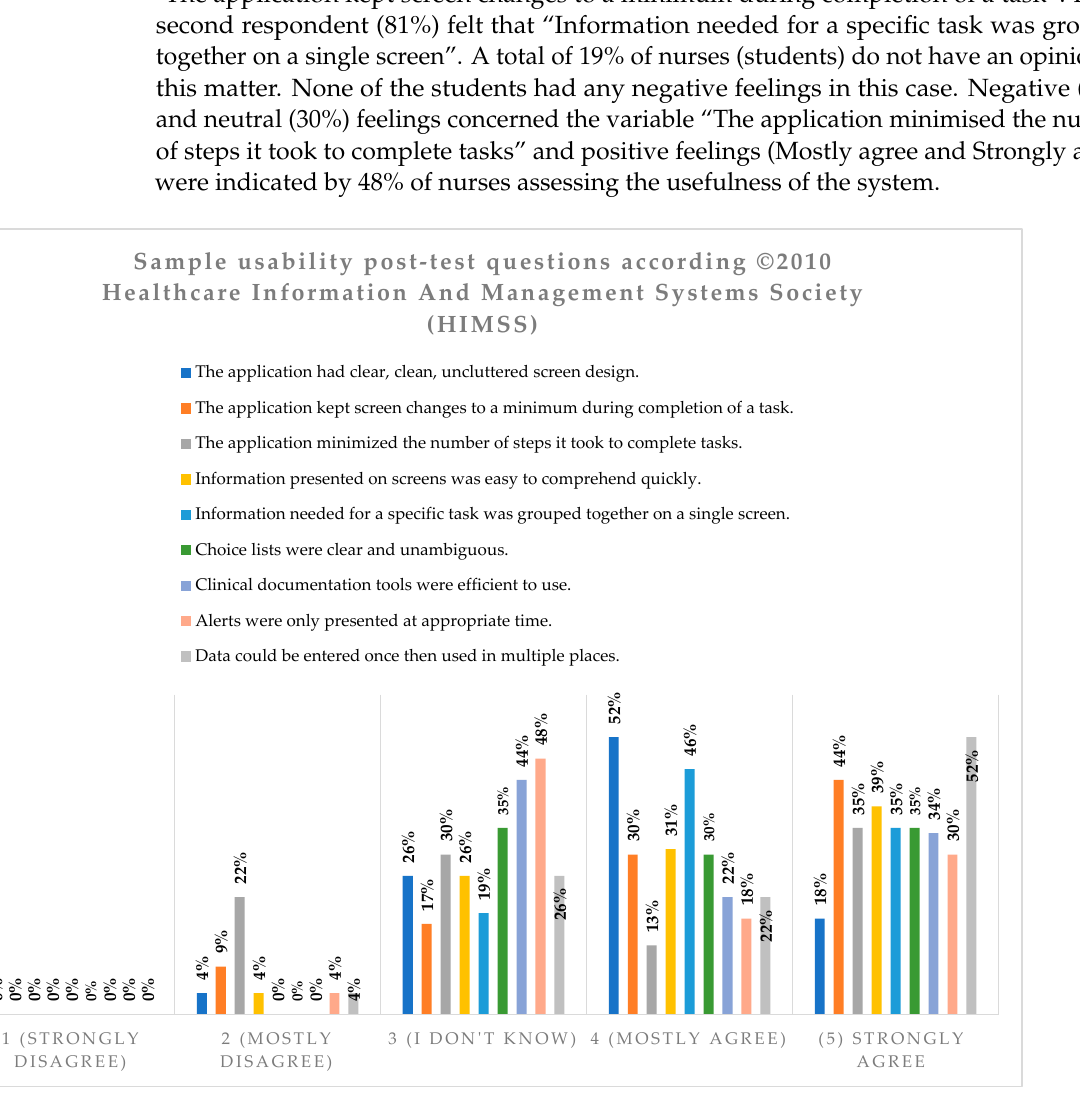
Figure 12. Characteristics of the ADPIECare system user interface. The assessment of ADPIECare system by nurses.